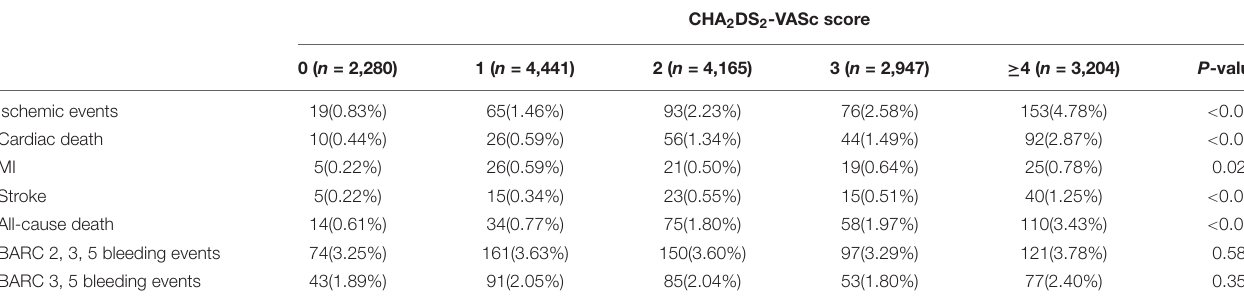
TABLE 1 | Clinical outcomes over 12 months according to the CHA 2 DS 2 -VASc score.